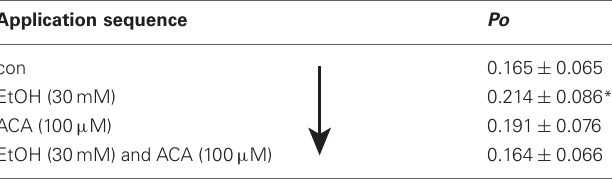
Table 3 | Sequence ( ↓ ) of application from top to bottom: con–EtOH–ACA–EtOH and ACA together.